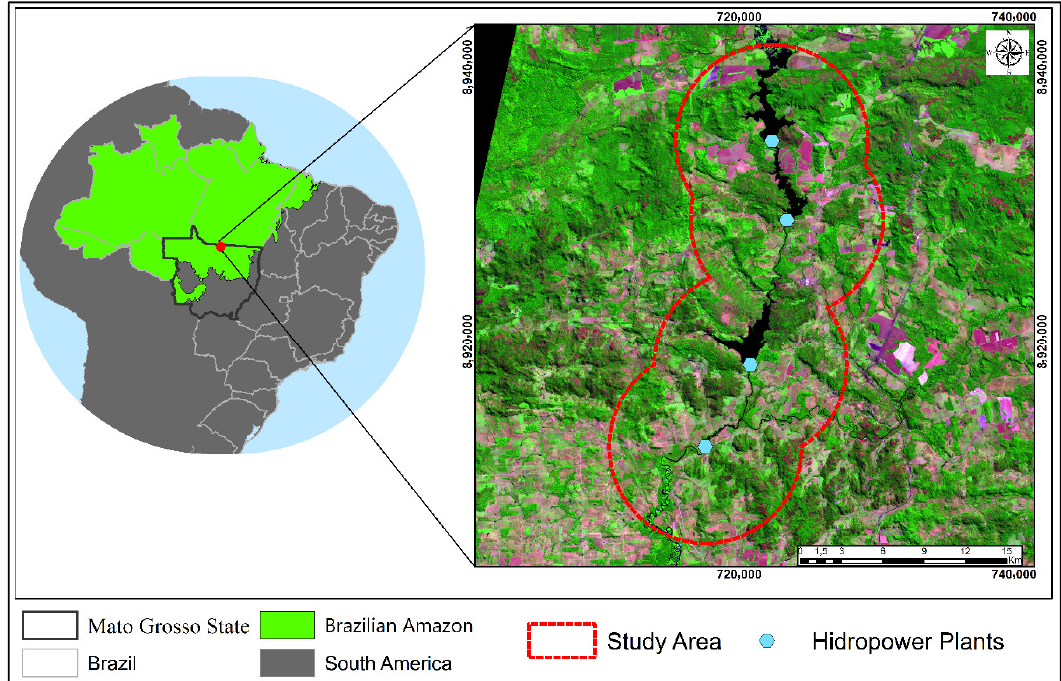
Figure 1. Location of the study area in South America, the Brazilian territory, the Brazilian Amazon, and the Mato Grosso State. Red polygon represents the direct influence zone of the Braço Norte Hydropower Complex.